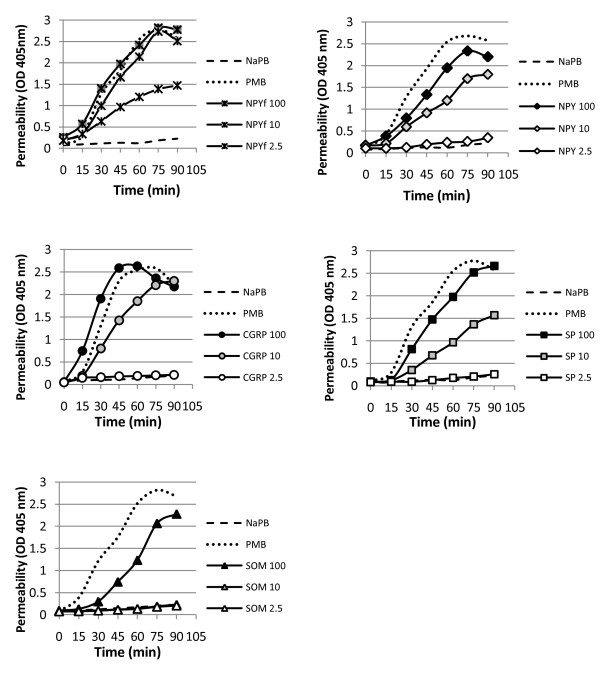
Permeabilizing potency of neuropeptides againstE.coliML-35p, determined by β-galactosidase assay with ONPG as its substrate. Bacteria at 106 CFU/ml were incubated at 37°C for 90 min in the presence of the indicated micromolar concentrations of neuropeptides: neuropeptide Y (NPY), fragment of neuropeptide Y (NPYf = NPY18–36), calcitonin gene related peptide (CGRP), substance P (SP), and somatostatin (SOM). In negative controls, bacteria incubated in neuropeptide-free NAPB containing 1/100 of TSB showed no net hydrolysis of ONPG. Polymyxin B (PMB) at 1 μg/ml was included as a positive control. The representative curves of at least three independent experiments are presented.